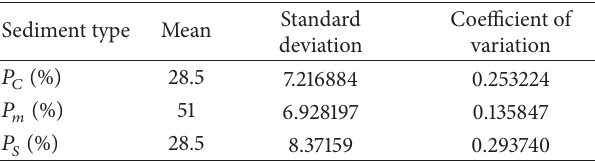
Table 6: Statistical properties of stochastic inputs for uncertainty